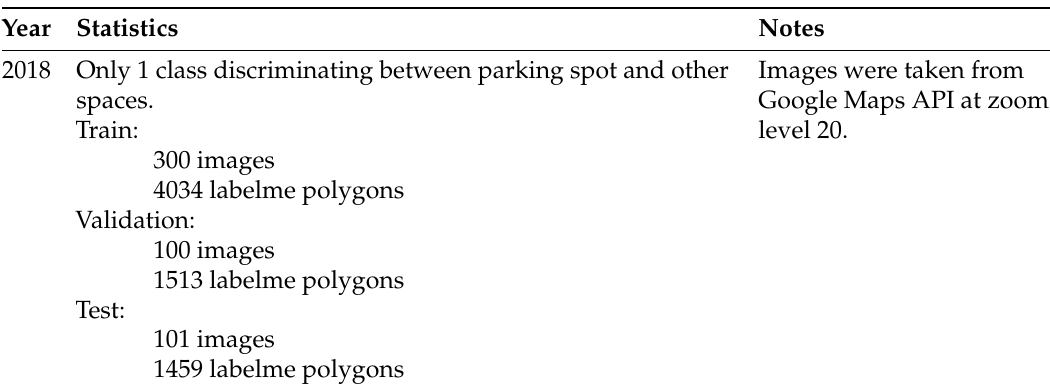
Table 1. Image sets in APKLOT .